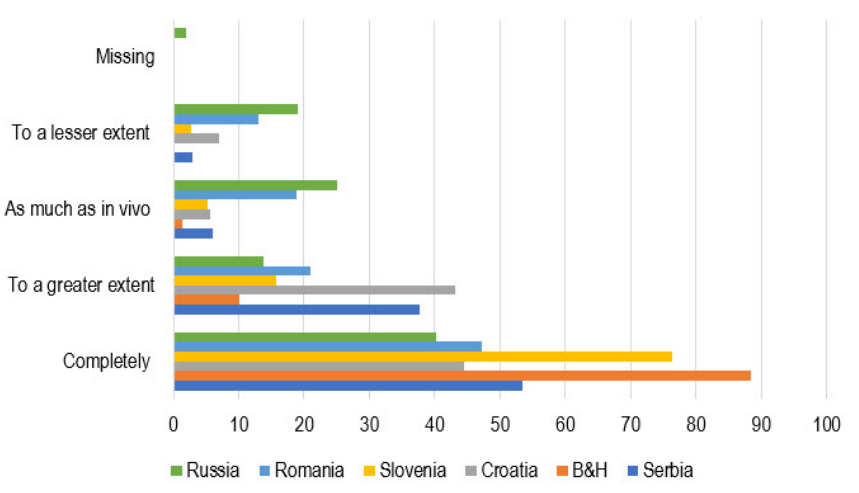
Figure 1. The extent to which online teaching was represented by